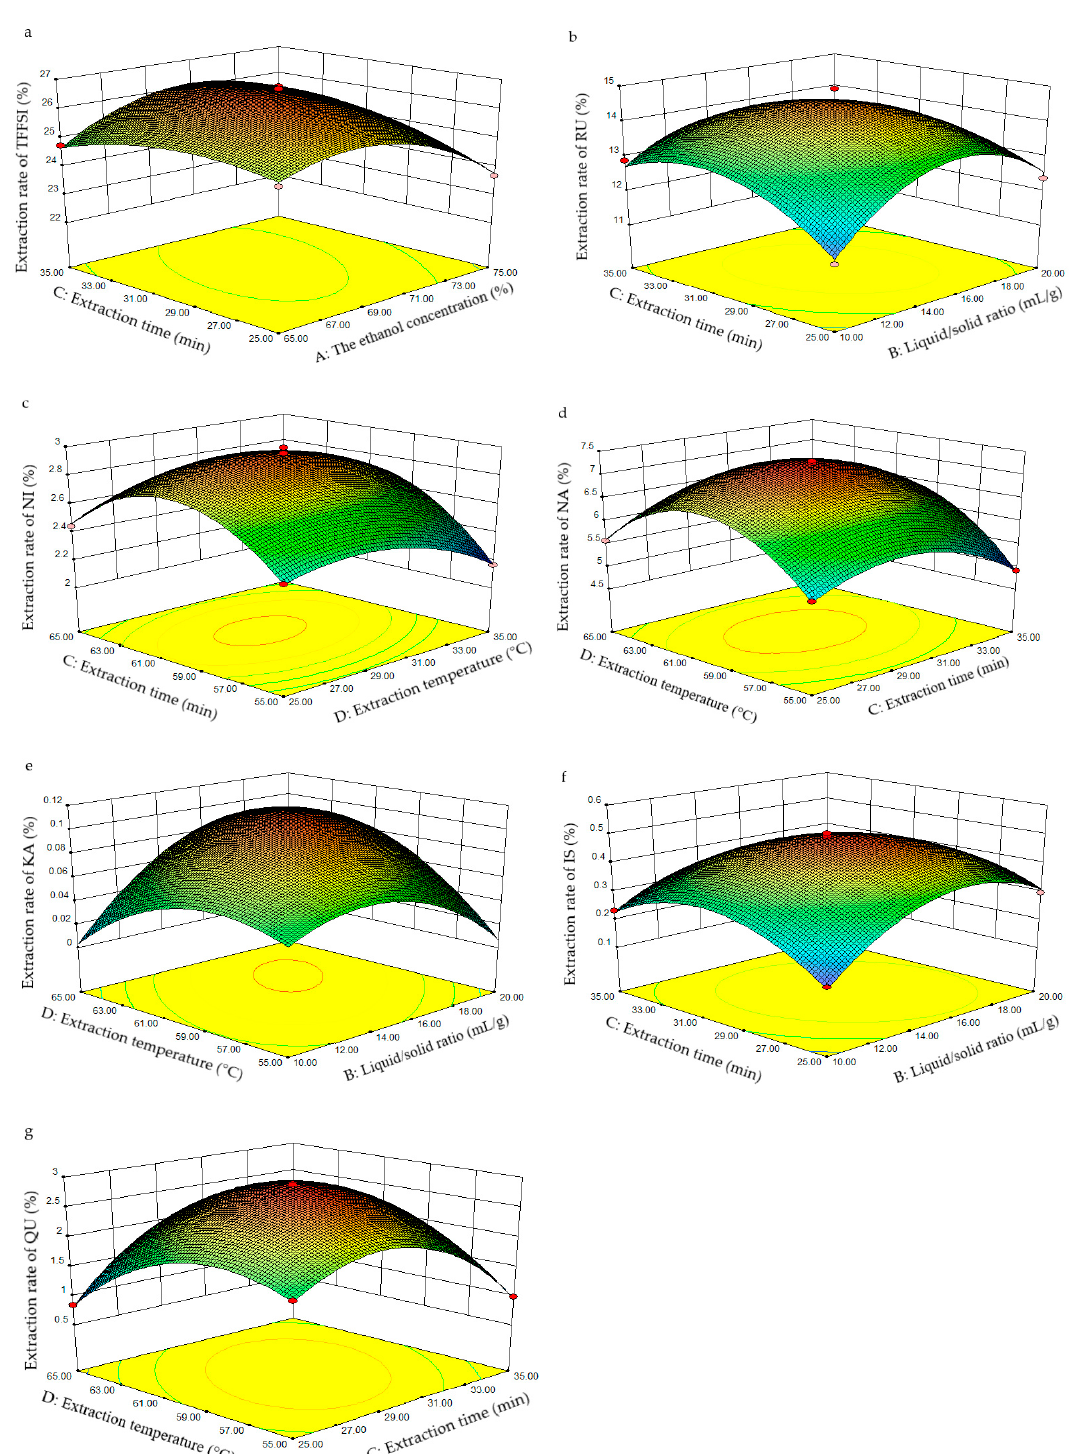
Figure 7. The response surfaces of the TFFSI ( a ), RU ( b ), NI ( c ), NA ( d ), KA ( e ), IS ( f ), and QU ( g ) from Flos Sophorae Immaturus: ( a ) varying the ethanol concentration and ultrasound extraction time; ( e ) varying liquid / solid ratio and ultrasound extraction temperature; ( b and f ) varying liquid / solid ratio and ultrasound extraction time; and ( c , d , and g ) varying ultrasound extraction temperature and ultrasound extraction